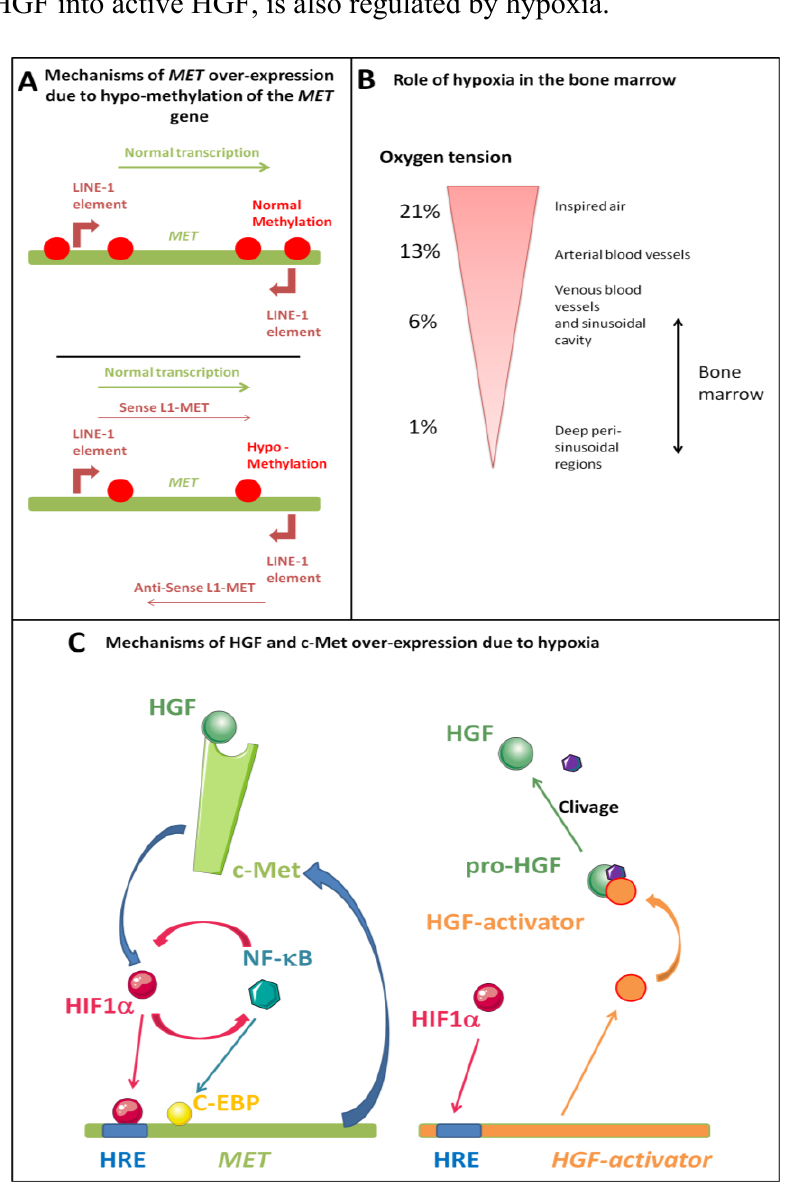
Figure 4. Molecular mechanisms of activation of the HGF/Met axis. ( A ) Mechanisms of MET over-expression: Hypomethylation of the LINE-1 (L1) retrotransposon promoter was reported during CML blast crisis; patients with hypomethylated L1 showed activation of MET transcription; ( B ) In chronic myeloproliferative diseases, cells accumulate in the bone marrow, which can result in local hypoxia and subsequent up-regulation of HGF. In mammals, air oxygen tension, around 21% when inspired, drops to around 6% in venous blood vessels and in the sinusoidal cavity of the bone marrow. In deep peri-sinusoidal regions, oxygen tension may be as low as 1%, indicating severe hypoxia in certain regions of the bone marrow; ( C ) HGF and Met expression can be induced by NF-  B and HIF-1  in a regulating loop, where NF-  B promotes HIF-1  , HGF and Met expression, and HGF may in turn regulate NF-  B negatively. The HGF activator (HGFA), a serine protease that cleaves pro-HGF into active HGF, is also regulated by